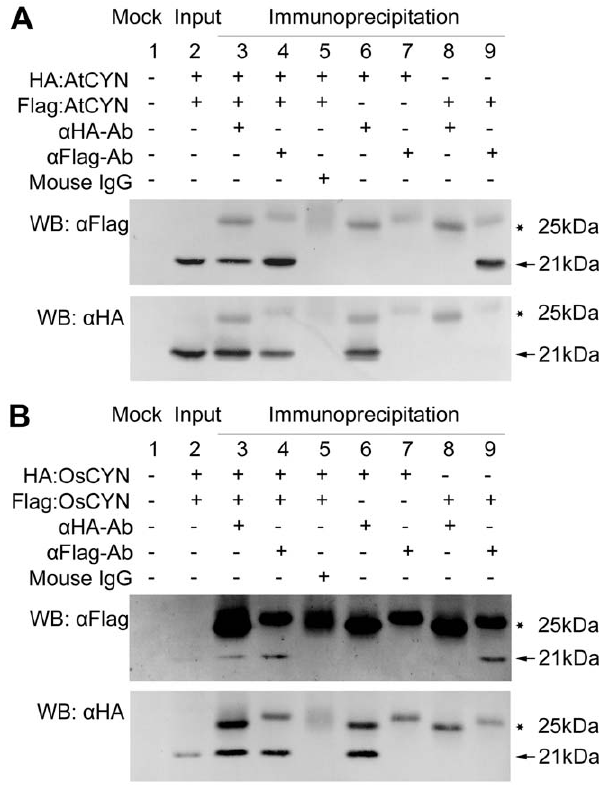
Figure 7. Coimmunoprecipitation assay demonstrating self- interaction of AtCYN (A) and OsCYN (B). Although an extremely low amount of OsCYN proteins was detected in the input samples, an identical pattern was shown by OsCYN in the assay. Lane 1: Mock; Lane 2: HA:CYN and FLAG:CYN were detected in the input samples; Lane 3: when anti-HA antibody was added, FLAG:CYN immunoprecipitated with HA:CYN (Lanes 6&8 were controls); Lane 4: when anti-FLAG antibody was added, HA:CYN immunoprecipitated with FLAG:CYN (Lanes 7&9 were controls); Lane 5: Native mouse IgG was used as negative control of antibodies. Bands of HA:CYN and Flag:CYN are indicated with arrows and bands of mouse IgG are indicated with stars.